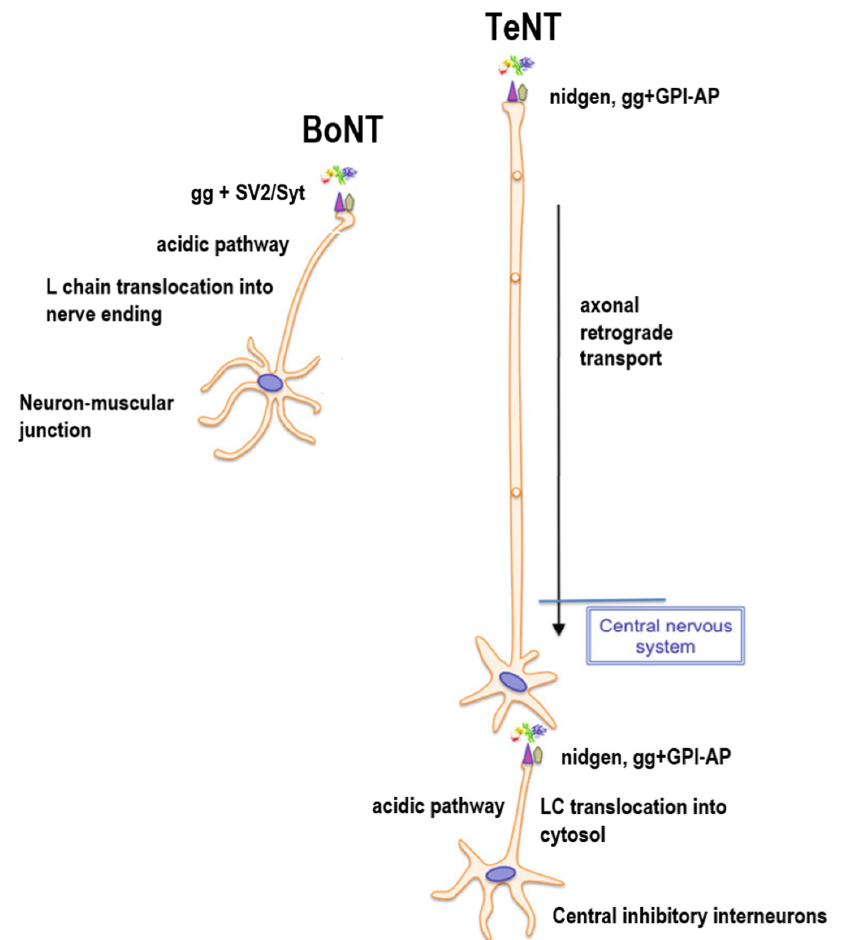
Figure 5. Target neurons of BoNTs and TeNT and their trafficking (modified from Connan and Popoff 2017 [99]). BoNTs target motor neuron endings at the neuromuscular junction, while TeNT enters the motoneuron and sensory neuron endings, moves retrogradely along the axon, is transcytosed, and reenters the central inhibitory neurons.